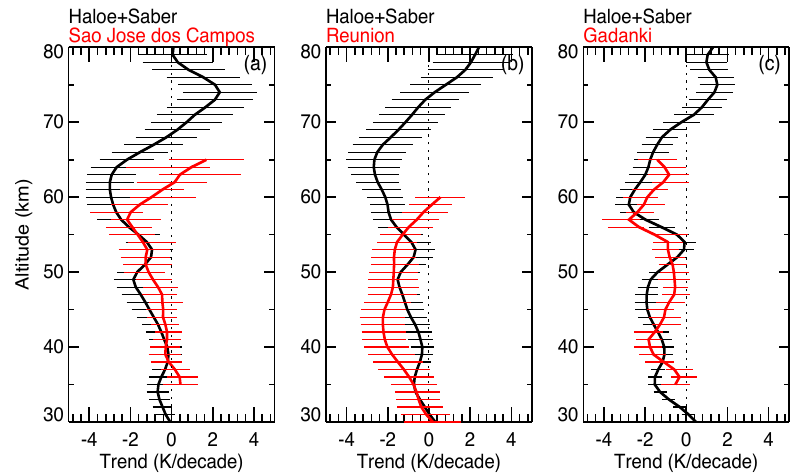
Fig. 10. Long-term trends observed at different altitudes obtained using combined measurements of HALOE and SABER measurements over (a) São José dos Campos, (b) Reunion, and (c) Gadanki locations. Trends observed using LIDARs at respective locations are also superimposed. Table 1. Long-term trends observed using different lidars along with that those observed from satellite observations over respective locations. The values reported in Remsberg (2009) are also provided. The ± 1 sigma uncertainties (standard deviations) are in parenthesis. Altitude São José dos Campos HALOE +